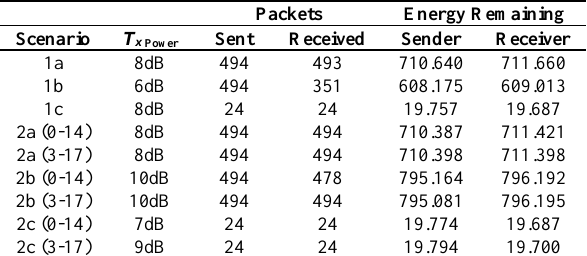
Table 22. Highest Number of Packets Received and Lowest Transmission